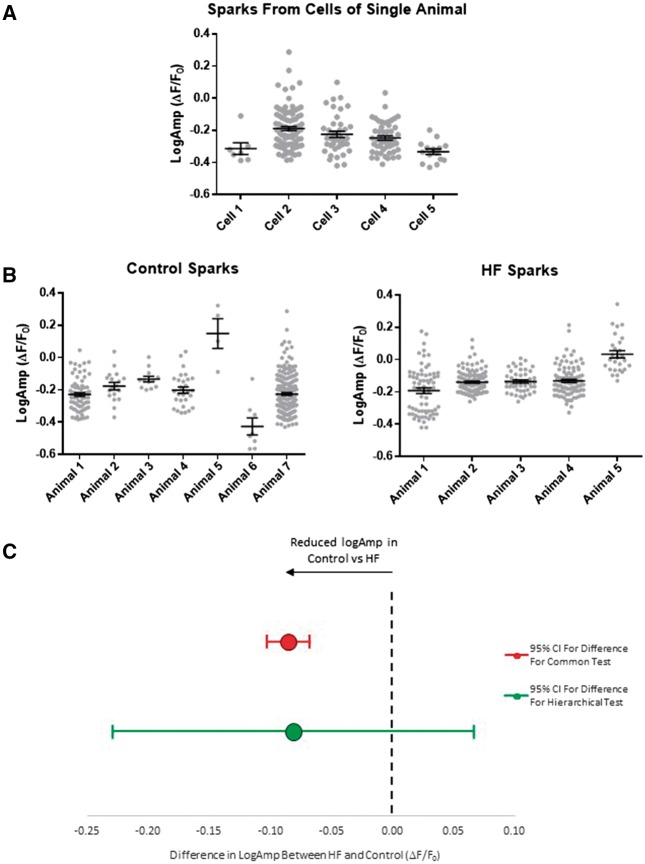
Multi-level clustering of spark logAmp. (A) Clustering of spark LogAmp is shown within each of five cells tested from a single rat heart. Each individual spark’s logAmp is shown as a grey dot. The mean and standard error bars are shown for each cell. By eye the data appear clustered at this level and this is confirmed in Table 3. (B) Spark data may also be further clustered within individual rats. Here sparks are shown grouped by rat. As confirmed in Table 3 there is also clustering at the level of the rat. (C) With two levels of clustering to correct for with a large ICC (58%) a large correction to confidence intervals is required. With the common test there is a highly significant difference comparing logAmp in HF and control (red bars). With the appropriate correction to confidence interval (green bars) it is clear there is no significant difference. There were 344 sparks from 17 cells from 7 control rats and 352 sparks from 22 cells from 5 HF rats.